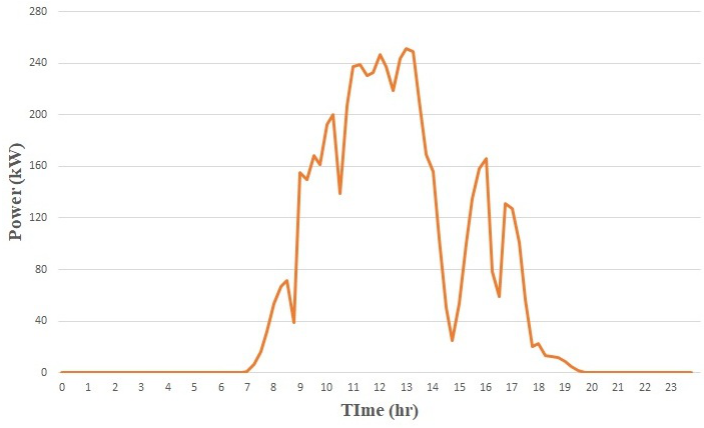
Figure 8. Power ramps at Daytona PV site during the 21 August 2017 partial